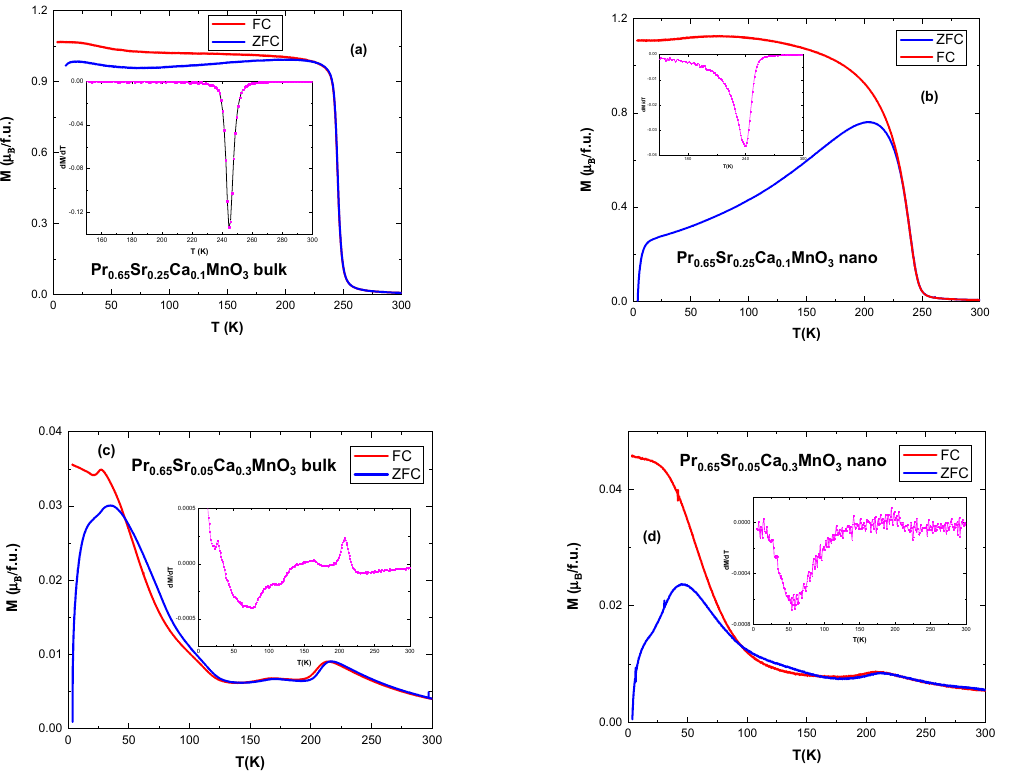
Figure 6. ZFC-FC plots in external field of 0.05 T ( a ) ZFC-FC curves and derivative of magnetization (inset) for the bulk sample Pr 0.65 Sr 0.25 Ca 0.1 MnO 3 ; ( b ) ZFC-FC curves and derivative (inset) for nanocrystalline sample Pr 0.65 Sr 0.25 Ca 0.1 MnO 3 . ( c ) ZFC-FC curves and derivative shown as inset, for polycrystalline sample Pr 0.65 Sr 0.05 Ca 0.3 MnO 3 ; ( d ) ZFC-FC curves and derivative shown in the inset for nanocrystalline sample Pr 0.65 Sr 0.05 Ca 0.3 MnO 3.